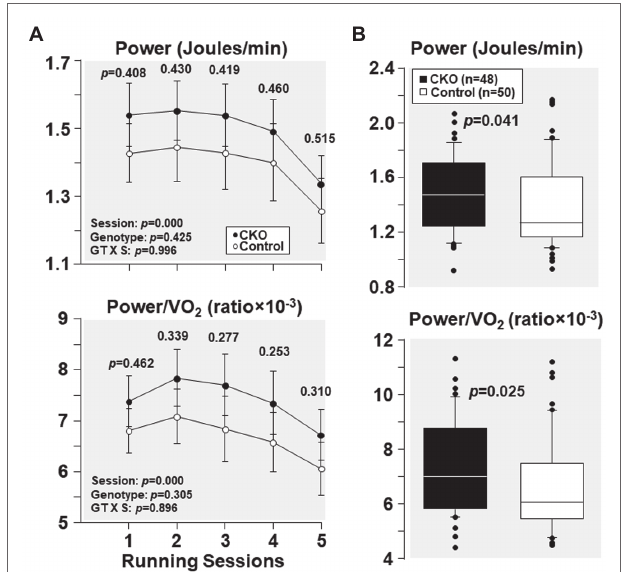
FIGURE 3 | (A) Power and power/VO 2 , at five running sessions by conditional cyclophilin-D knockout (CKO; n = 10) and control mice ( n = 10). Differences were analyzed by a linear mixed-effects model. Data from one CKO mouse were lost at running session four and five due to refusal of running. (B) Box plots depicting power (Joules/min) and power/VO 2 ratio during exercise in conditional cyclophilin-D knockout (CKO) and control mice. Differences were analyzed by Mann-Whitney rank sum